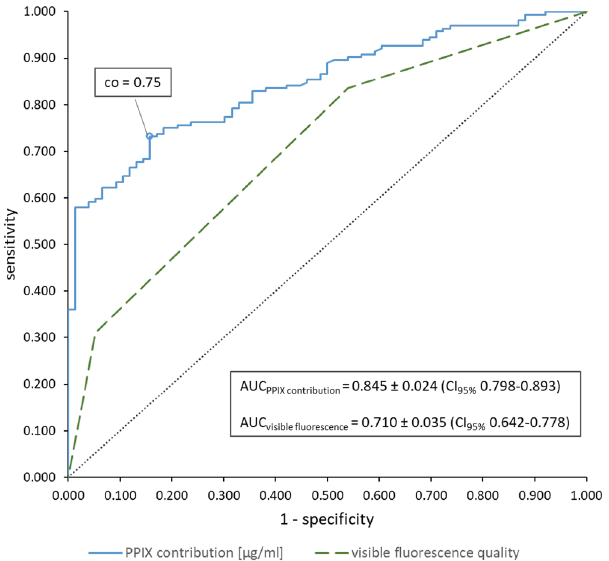
Figure 9. ROC analysis to find the optimal cut-off value (co) for the hyperspectrally measured PPIX contribution for diagnosis of tumor tissue (blue solid) and comparison with the visible observed fluorescence quality in the surgical microscope (green dashed) as diagnostic variables (black dotted = reference line).